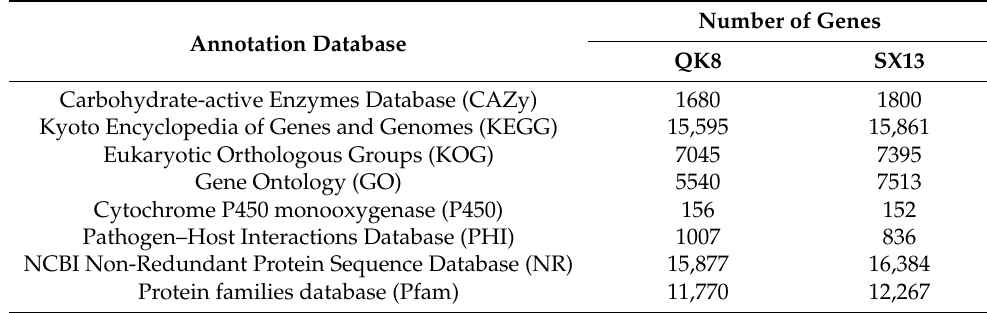
Table 2. Annotated summary table of two Fusarium strains QK8 and SX13.